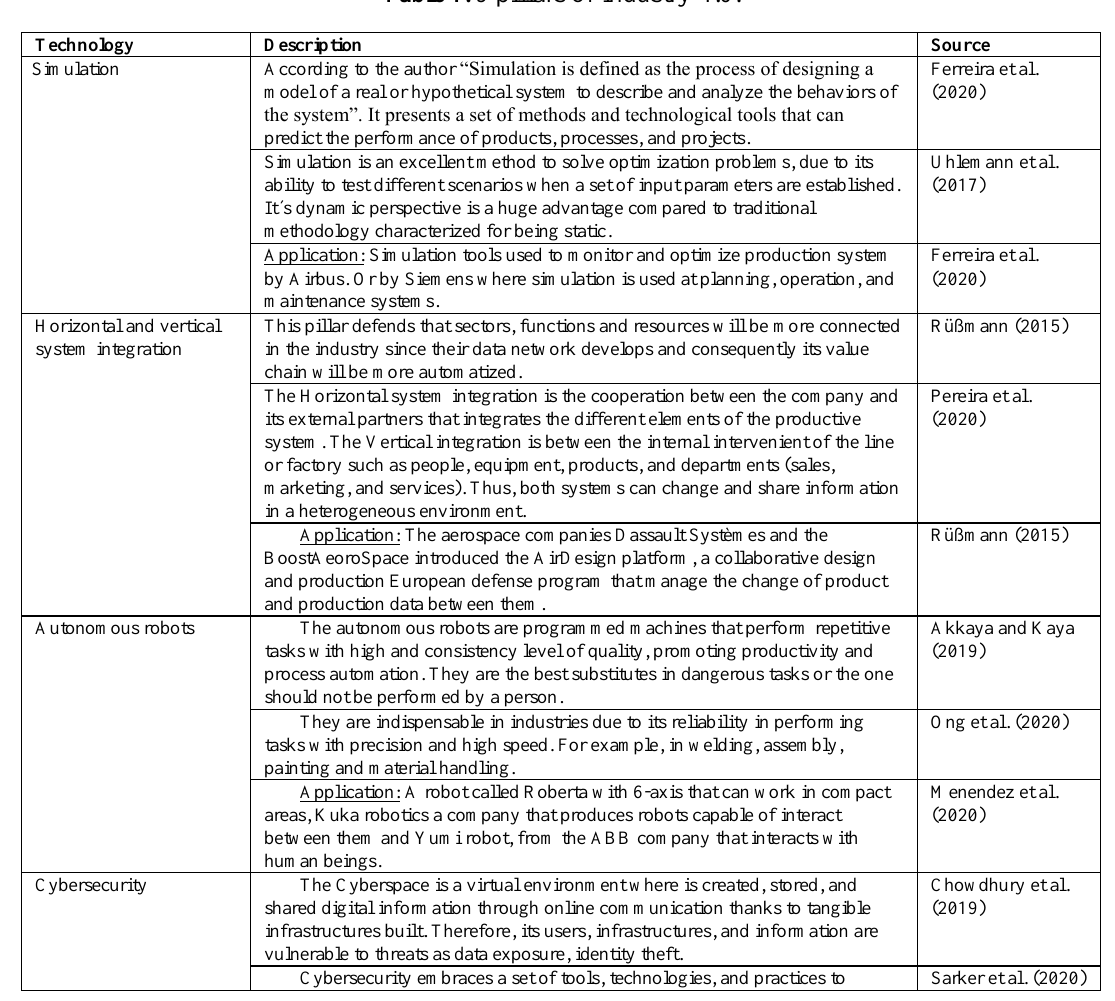
Table 1. 9 pillars of industry